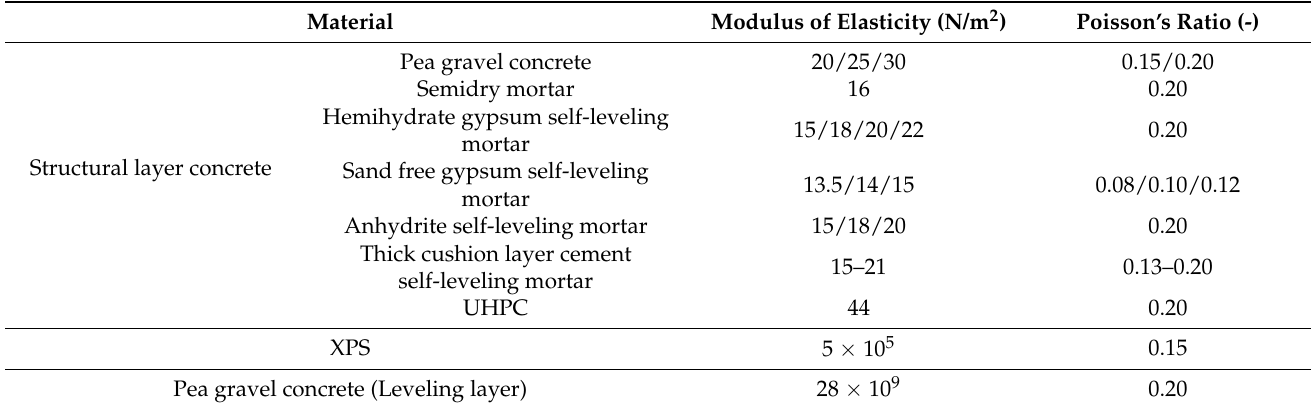
Table 1. Summary of mechanical parameters of